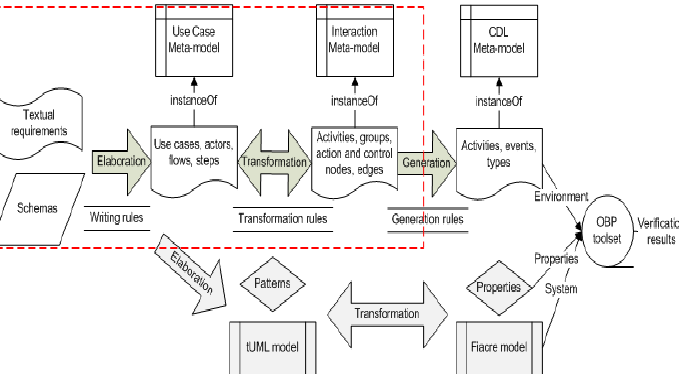
Figure 3. Methodology for a context-aware verification process